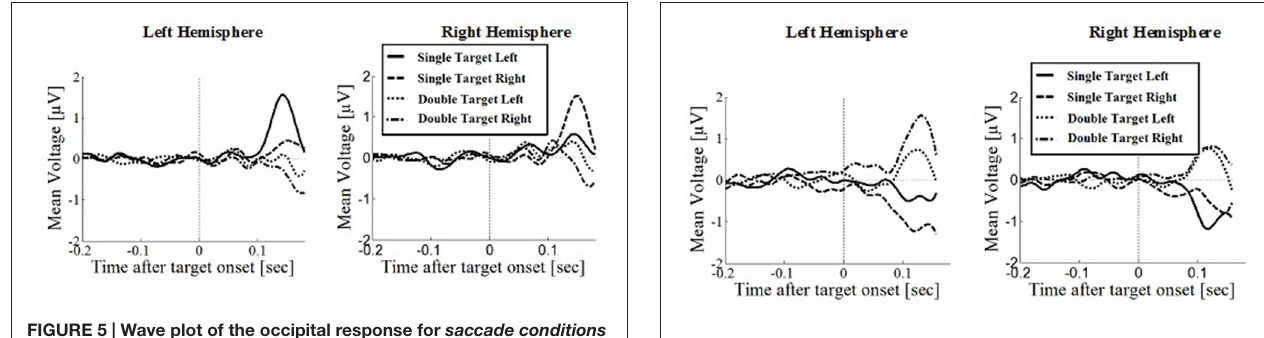
FIGURE 7 | Wave plot of the prefrontal response for saccade conditions in the left hemisphere (left) and the right hemisphere (right) of the brain.